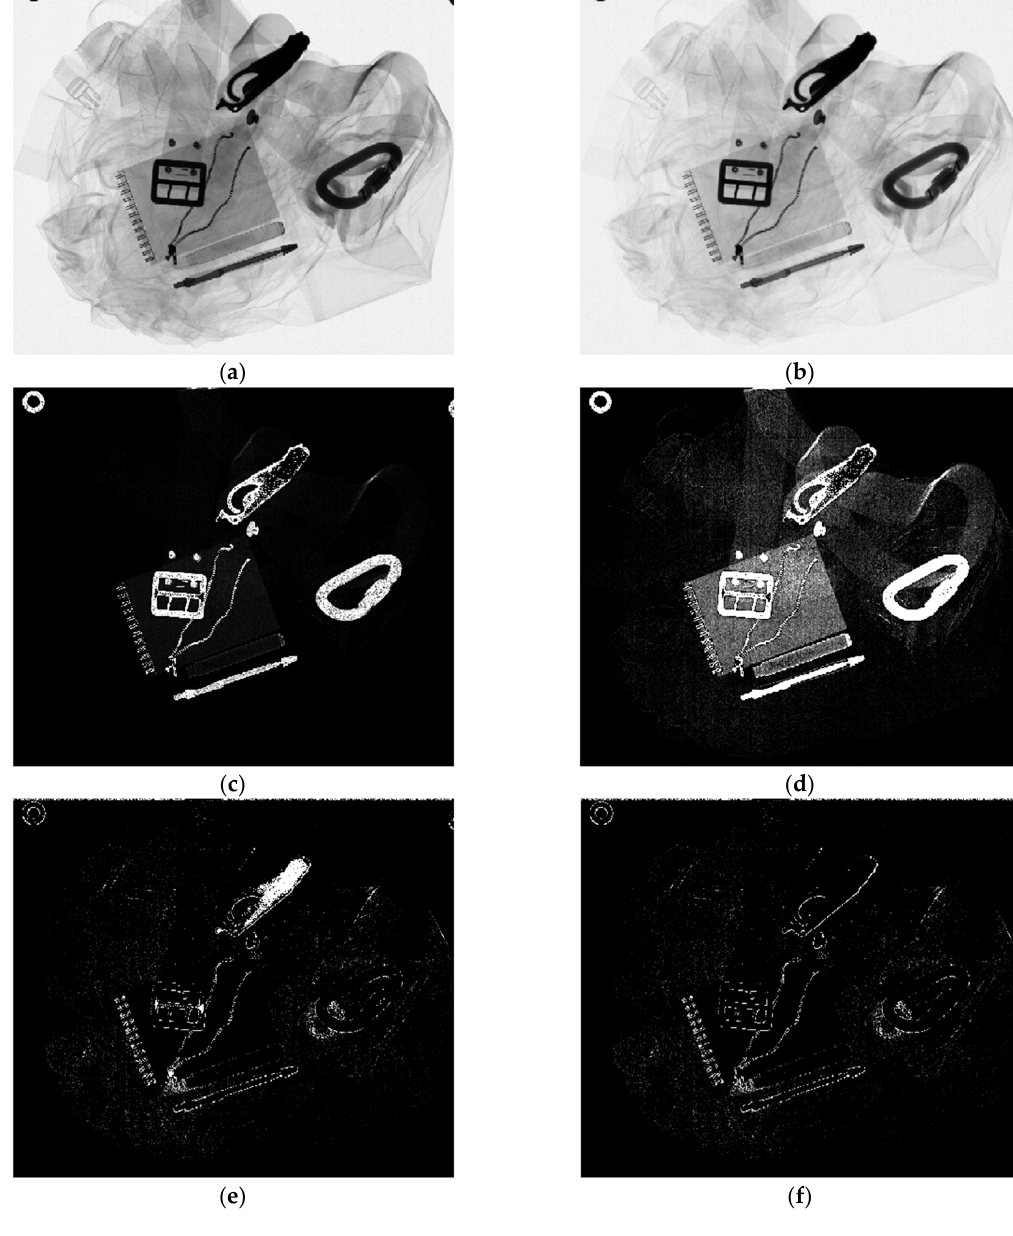
Figure 4. ( a ) Low ‐ energy image of the paramedical trousers (adapted from [26], licensed under CC BY 4.0); ( b ) high ‐ energy image; ( c ) areal density image with Z eff = 26; ( d ) areal density image with Z eff = 11.2; ( e ) areal density image with Z eff = 6; ( f ) areal density image with Z eff = 6 after removing areas of low X ‐ ray transmission. As the second basis material, Z eff = 7.1 was used in all cases.